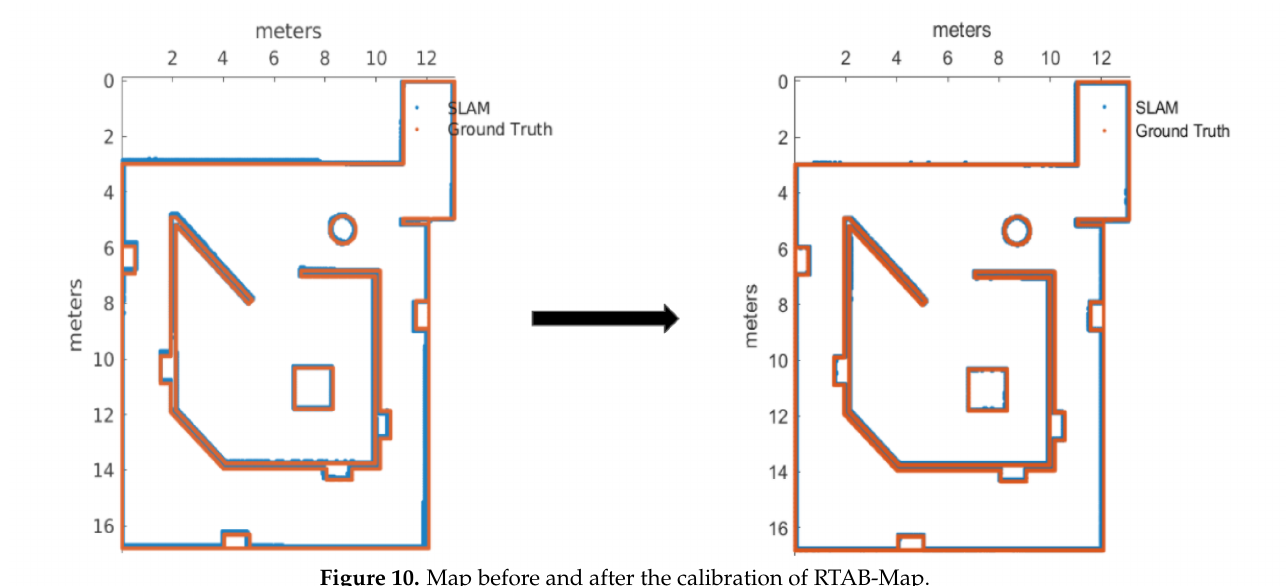
Figure 10. Map before and after the calibration of RTAB-Map.